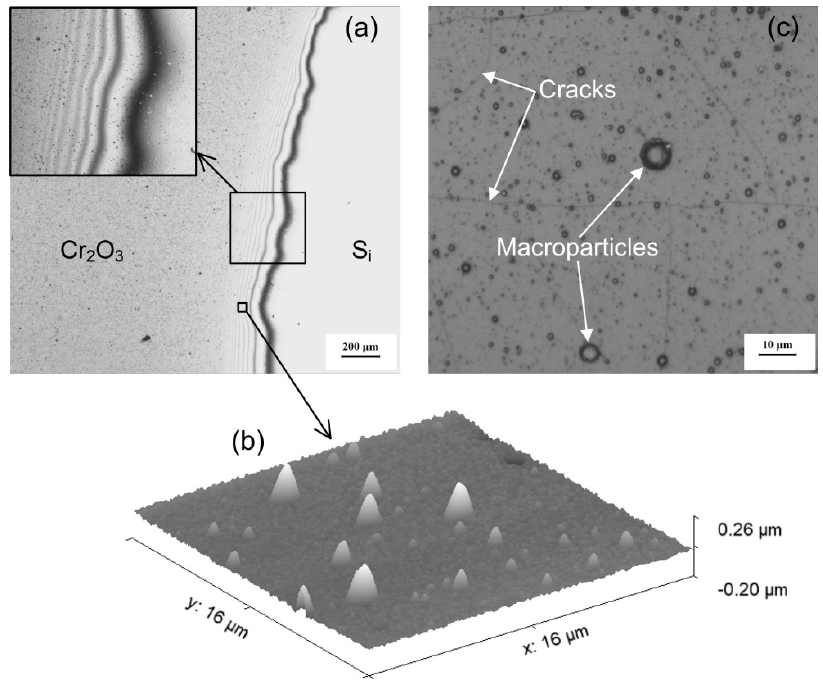
Figure 1. ( a ) Microscope image showing the morphology of the depositional edge zone of the Cr 2 O 3 coating; ( b ) Atomic force microscope image showing the morphology of the depositional edge zone of the Cr 2 O 3 coating; and ( c ) Microscope image showing macroparticles and cracks on the surface of the Cr 2 O 3 coating.